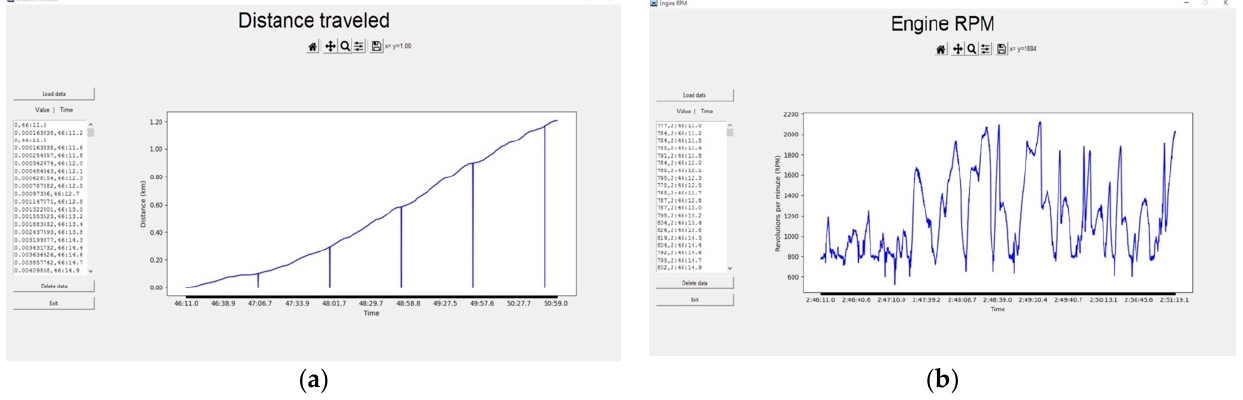
Figure 9. Data in the GUI: ( a ) is the distance traveled by the car and ( b ) is the RPM of the vehicle’s motor.